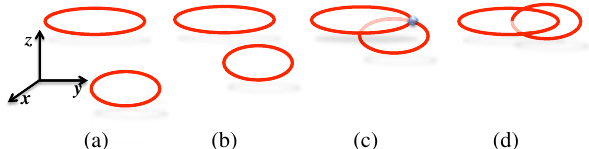
FIG. 2. Physical meaning of b ∧ b topological term. In (a) the larger loop denotes a vortex line that is static and located on the xy plane. The smaller loop is perpendicular to the xy plane, parallel to the yz plane, and moves toward the z direction. In (b), two loops get closer to each other than (a). In (c), two loops collide with each other. The blue dot in (c) denotes the intersection of two loops. In (d), two loops are eventually linked to each other. The presence of b ∧ b term will contribute a phase through this unlinking-linking